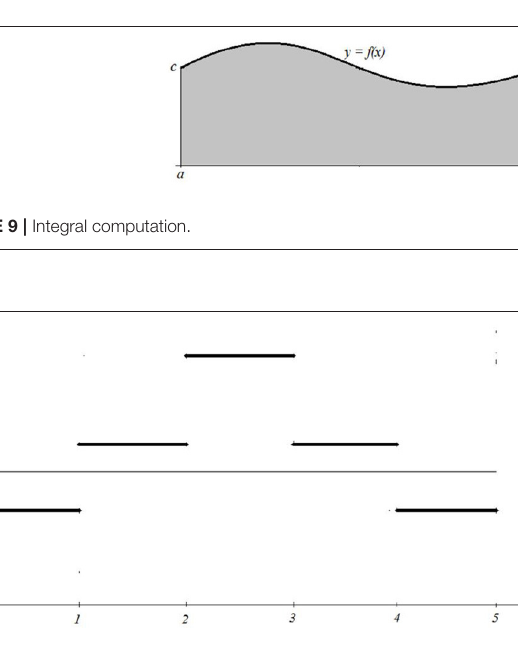
FIGURE 10 | Simple calculation of the mean and its